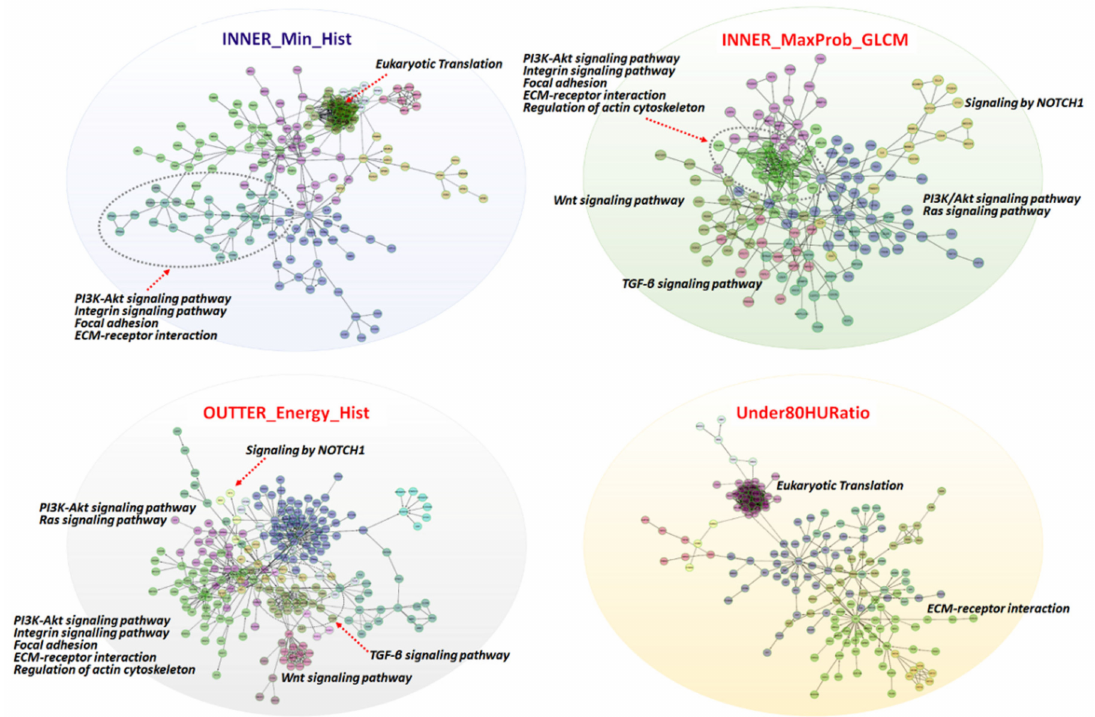
Figure 4. Gene–gene interaction network analysis of trait-associated genes. Gene–gene interaction networks visualized for four radiomic features. Functional gene modules are shown in di ff erent colors, and major pathways are